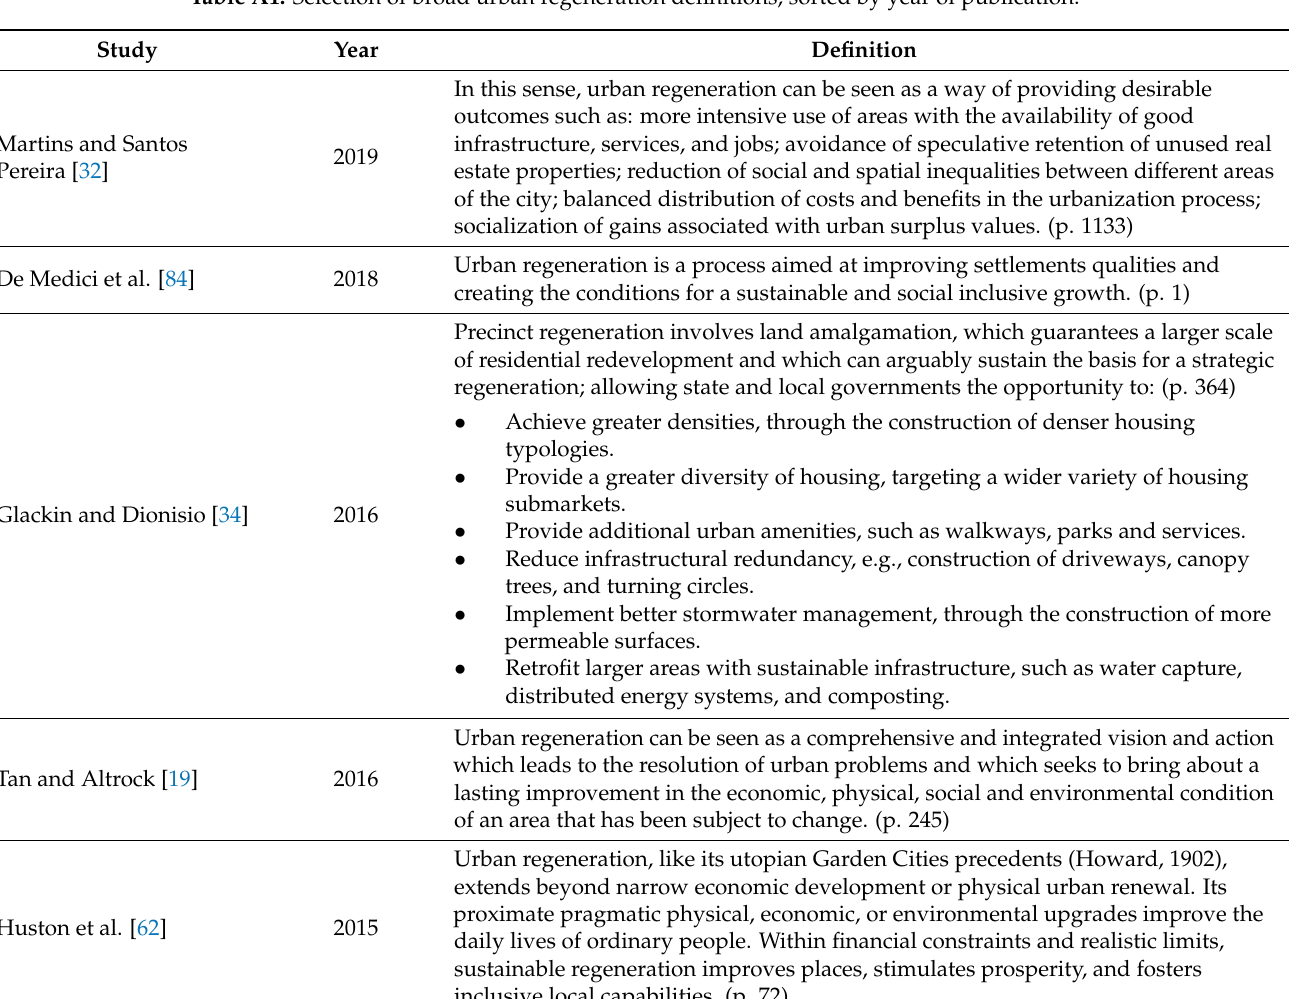
Table A1. Selection of broad urban regeneration definitions, sorted by year of